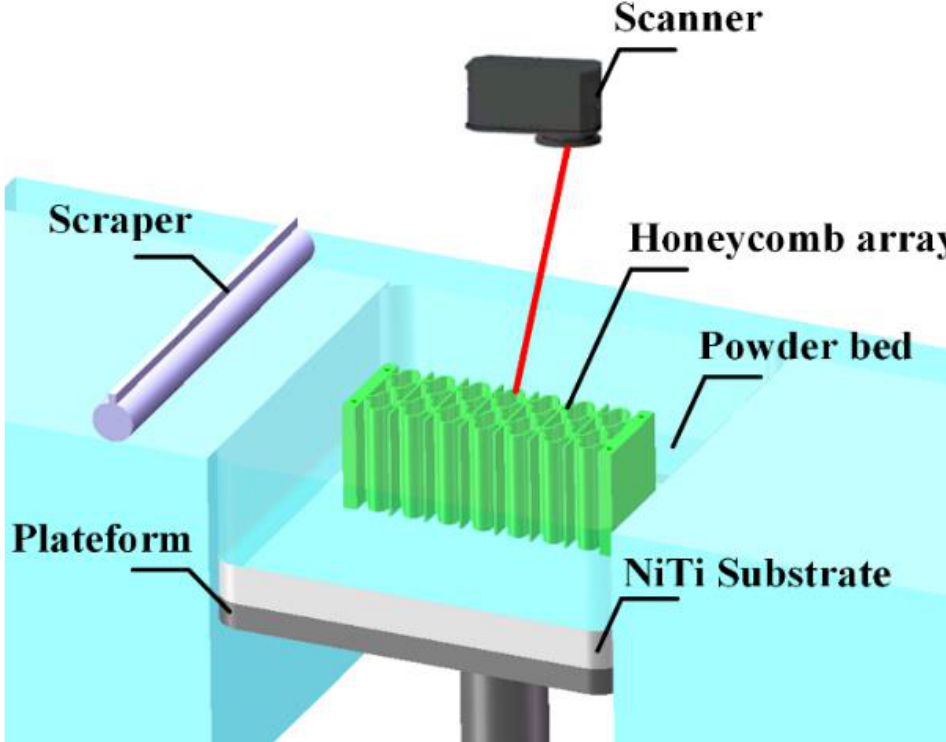
Figure 5. SLM process of manufacturing active SMA honeycomb arrays.